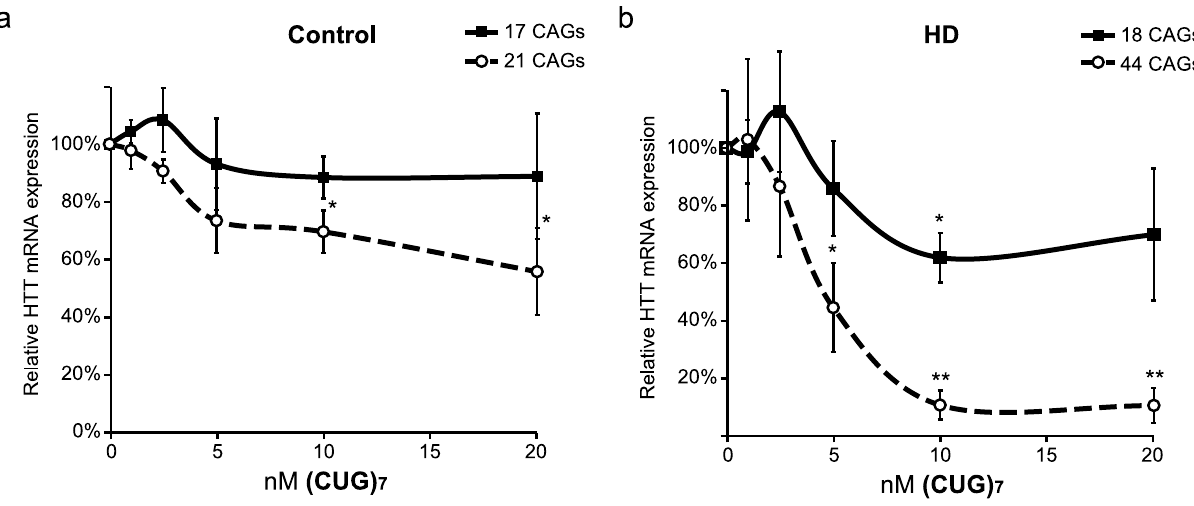
Figure 4. Effect of various (CUG) 7 AON concentrations on HTT mRNA expression. Cells were transfected with 1–20 nM (CUG) 7 . PCR products with primers flanking the CAG repeat of HTT were quantified by Lab on a Chip. (a) In the control cell line (FLB73) both alleles (17 and 21 CAGs) show a comparable concentration dependent reduction of HTT mRNA quantification after (CUG) 7 transfection. (b) In HD fibroblasts (GM04022) the mutant transcript, with 44 CAGs, shows a strong reduction of mutant HTT mRNA expression with increasing (CUG) 7 AON concentrations, whereas the normal HTT transcript with 18 CAGs is reduced to a lesser degree. Expression levels are corrected for loading differences with ACTB and mRNA levels of the Mock I transfections were set on 100% (* P , 0.05, ** P , 0.01,